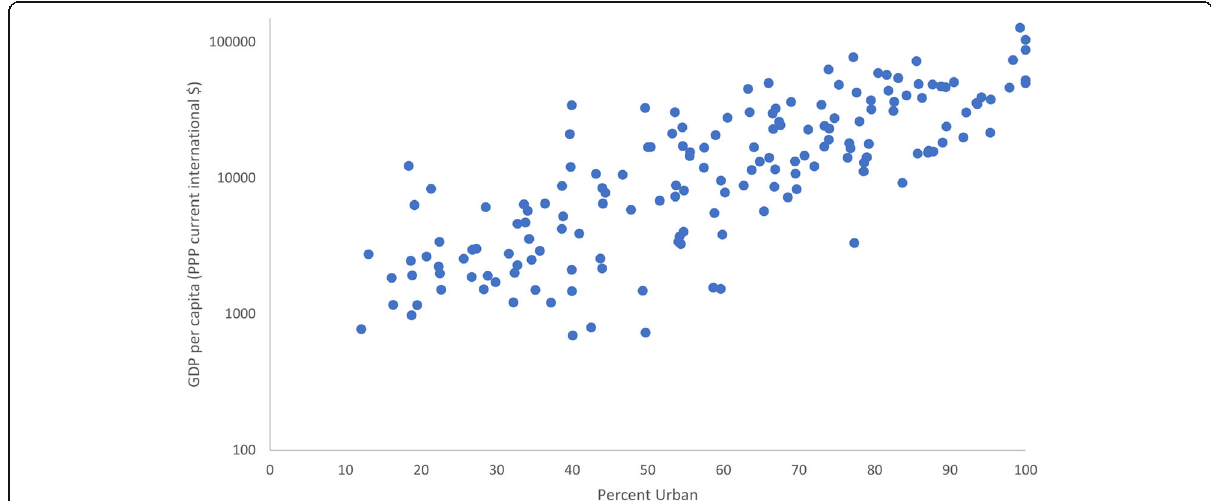
Fig. 2 Urbanization and economic development. The relationship between the percent urban of a country ’ s population and its GDP per capita. Urbanization data taken from the UNPD for 2015. Per-capita GDP taken from the World Bank. Some small island states and nations are excluded from this graph, as are nations with missing data